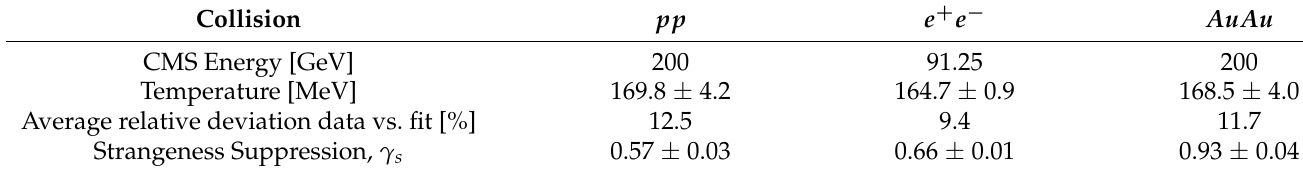
Table 1. Fit results for a set of 12 long-lived particles in high energy pp , AuAu and e + e − collisions [22].